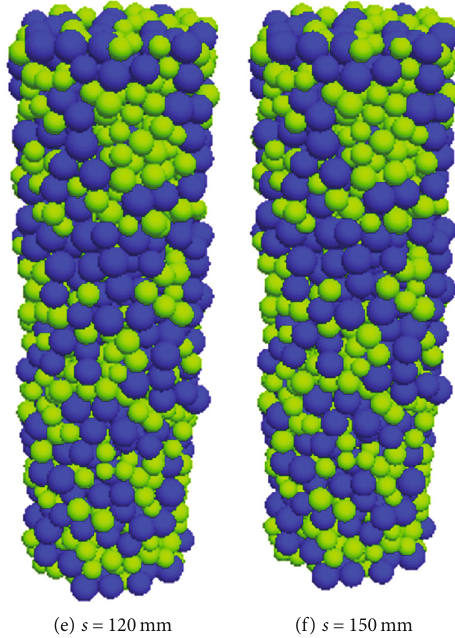
Figure 8: Deformation of the column during